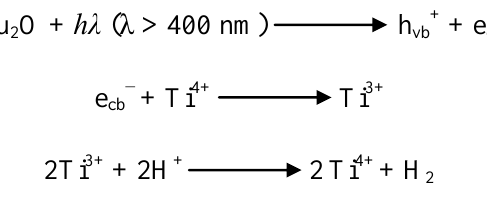
Figure 16. Curve of H yield as the function of time under and after visible-light 2 irradiation